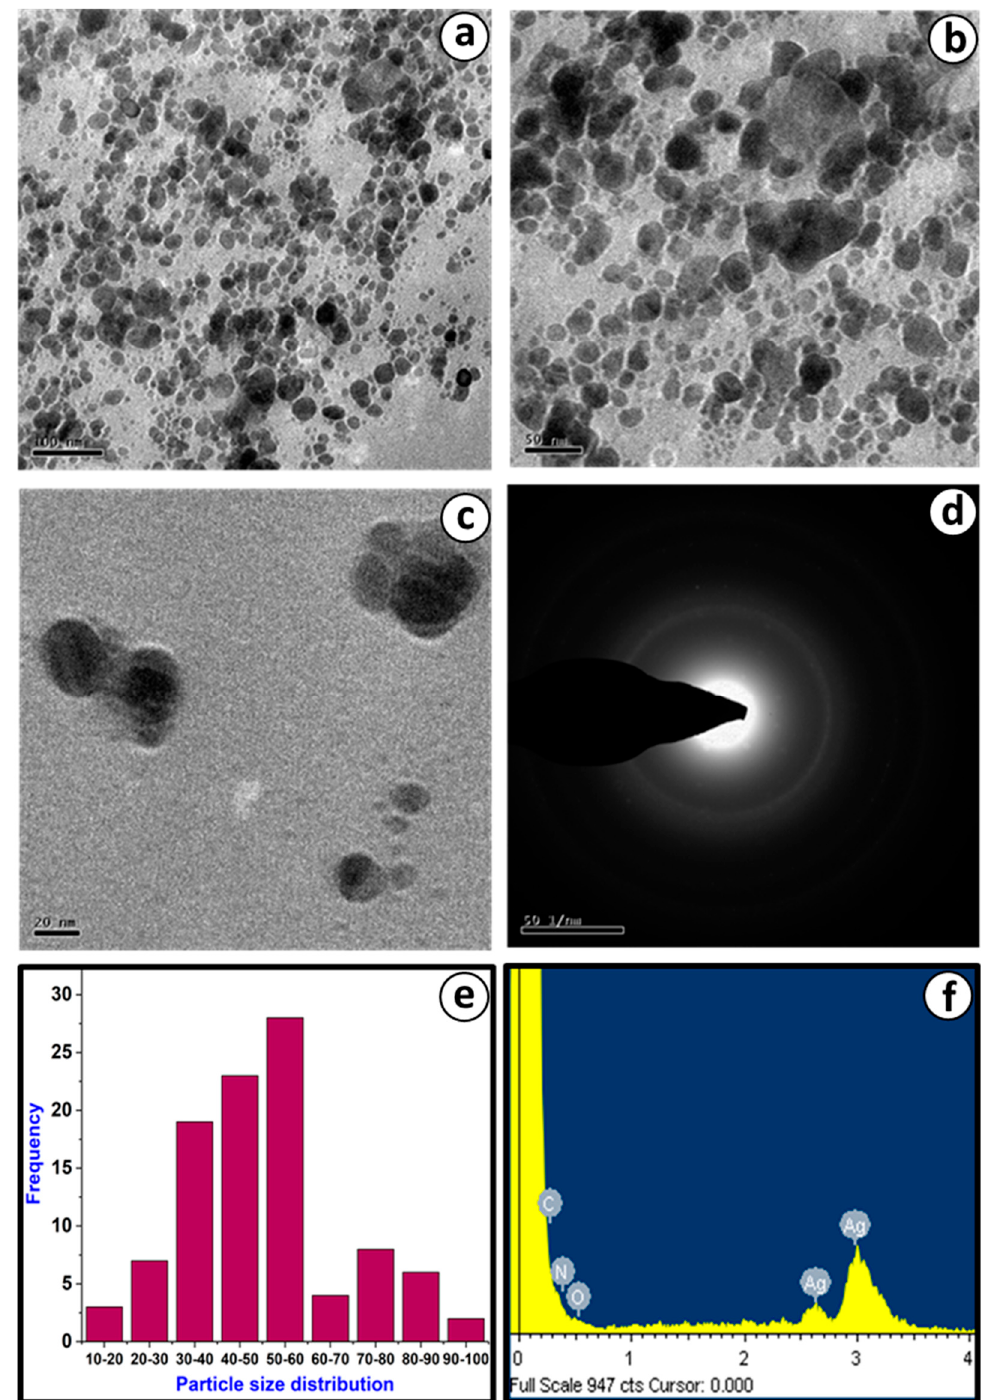
Figure 5. ( a – c ) TEM analysis of PoAgNPs. ( d ) SAED pattern of PoAgNPs. ( e ) Particle size histogram of PoAgNPs. ( f ) EDAX analysis of PoAgNPs.